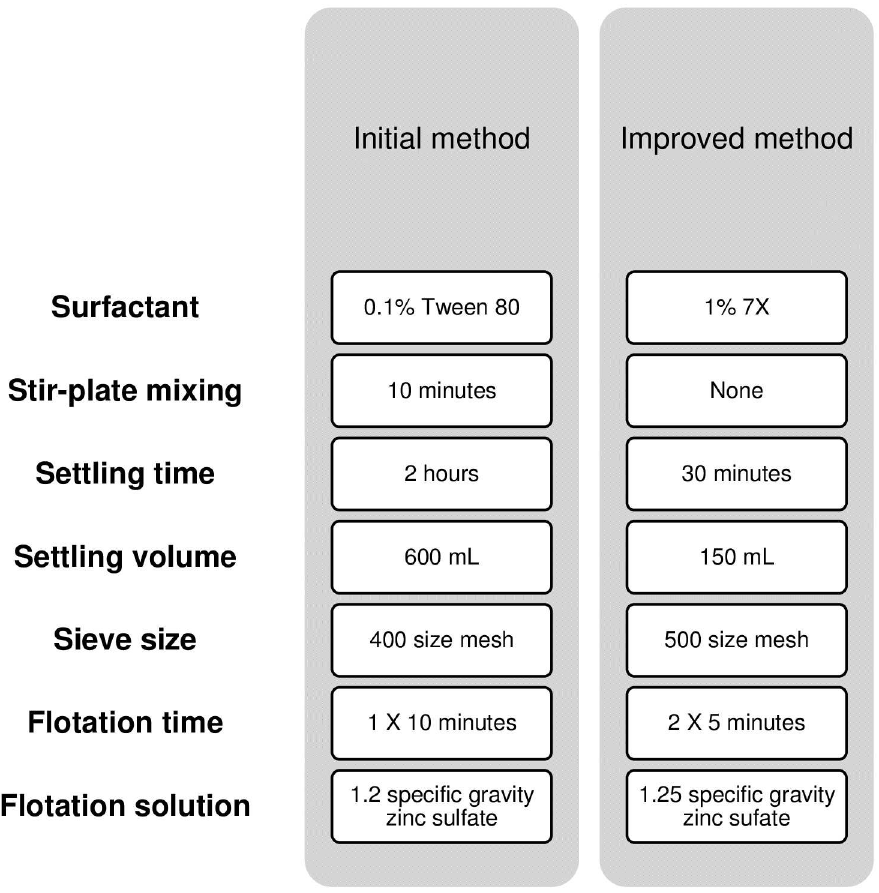
Fig 3. Comparison of initial and improved method for extracting STH eggs from soil.